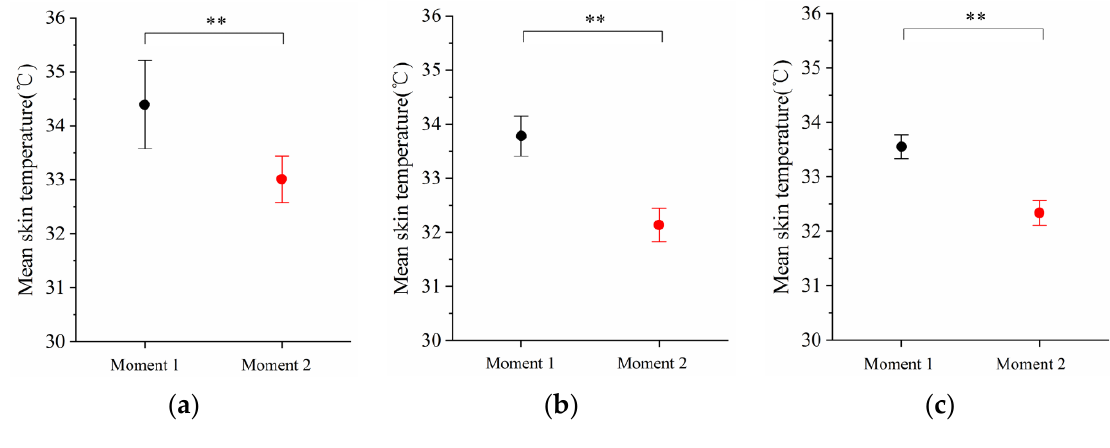
Figure 10. Interval plot of mean skin temperature by moment 1 (at 30 min) and moment 2 (when behavior intention of turning off air conditioning occurred) in scenario B, C, and D. (( a ): scenario B,